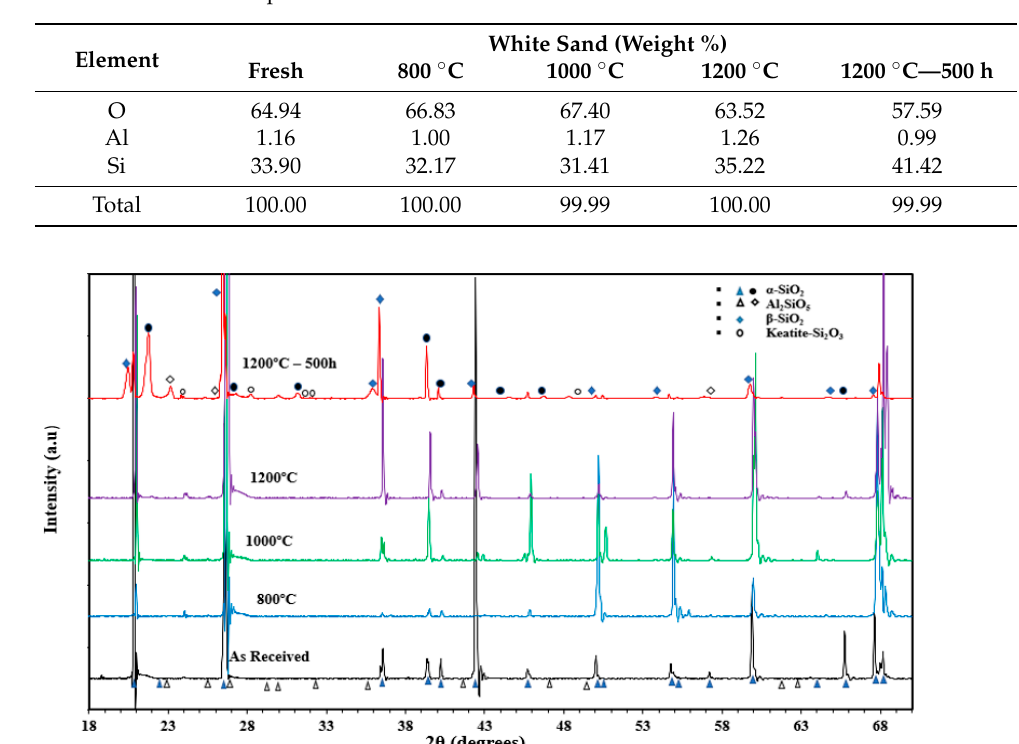
Figure 6. XRD data for white sand in the “as received” condition, following heating in air at different temperatures, and after cyclic heating at 1200 °C for 500 h.